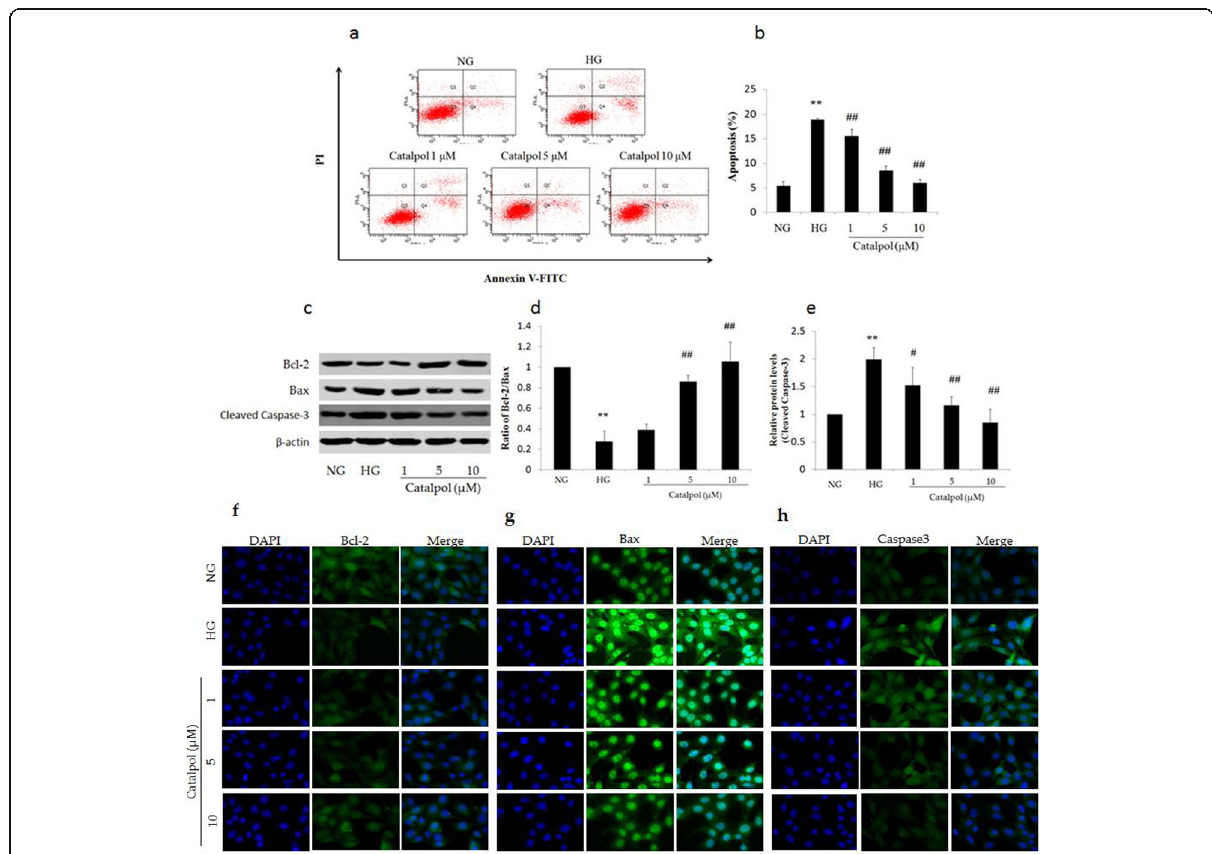
Fig. 4 The anti-apoptotic effect of catalpol on HG-induced podocyte injury. a Populations of apoptotic podocytes sorted by flow cytometry. b Histogram of the apoptosis rate of podocytes ( n =3). c Bax, Bcl-2, and cleaved caspase-3 detection in podocytes by western blotting. d Histogram of the Bcl-2/Bax ratio in podocytes ( n = 3). e Relative level of cleaved caspase-3 to β -actin in podocytes ( n = 3). f Immunofluorescence staining for Bcl-2. g Immunofluorescence staining for Bax h Immunofluorescence staining for caspase-3. Data are presented as the mean±SD. ** p <0.01 vs NG, # p <0.05, ## p <0.01 vs